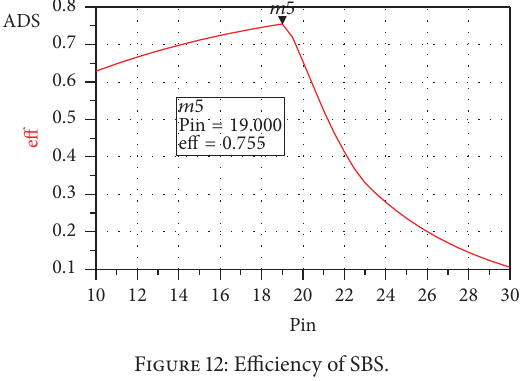
Figure 9: Input impedance of SBS.